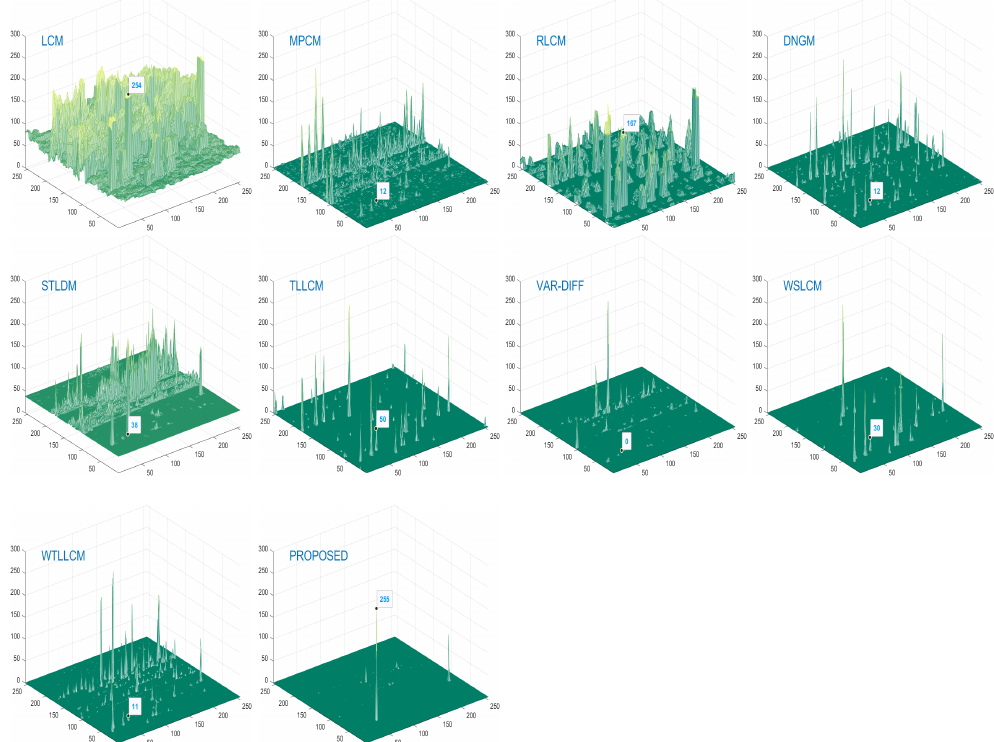
Figure 20. Three-dimensional displays of detection results on one frame in data3. Different subgraphs are the results of different